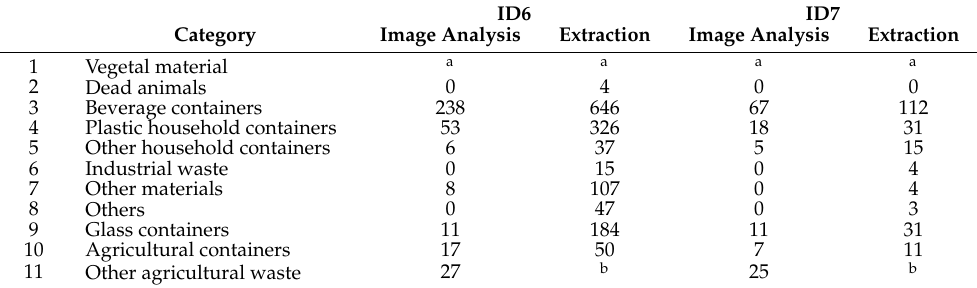
Table 4. Results of count of items of different categories in accumulation points ID6 (syphon at Acequia de Callosa ) and ID7 (syphon at Azarbe de Cebadas ) by image analysis and after extraction of